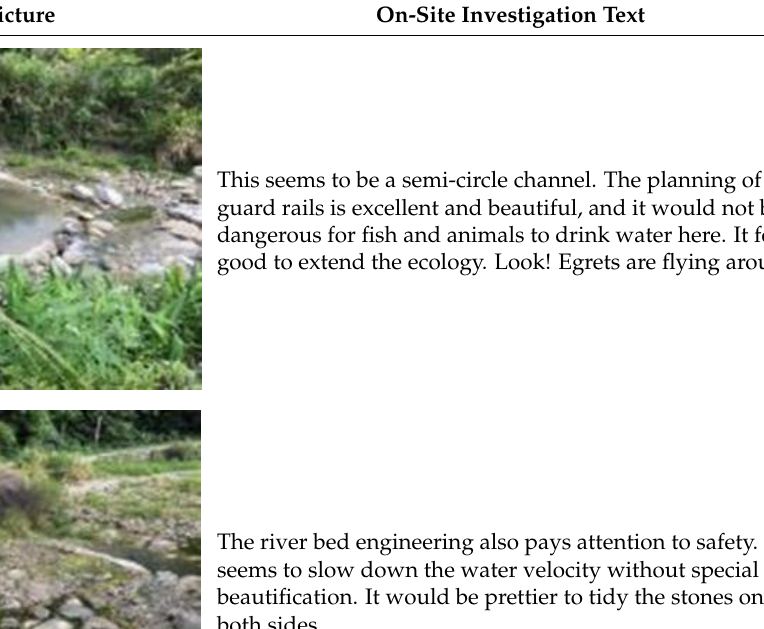
Table 3. On-site investigation of the “Upstream Renovation Project of Toubiankeng Stream in Zhongpu”.